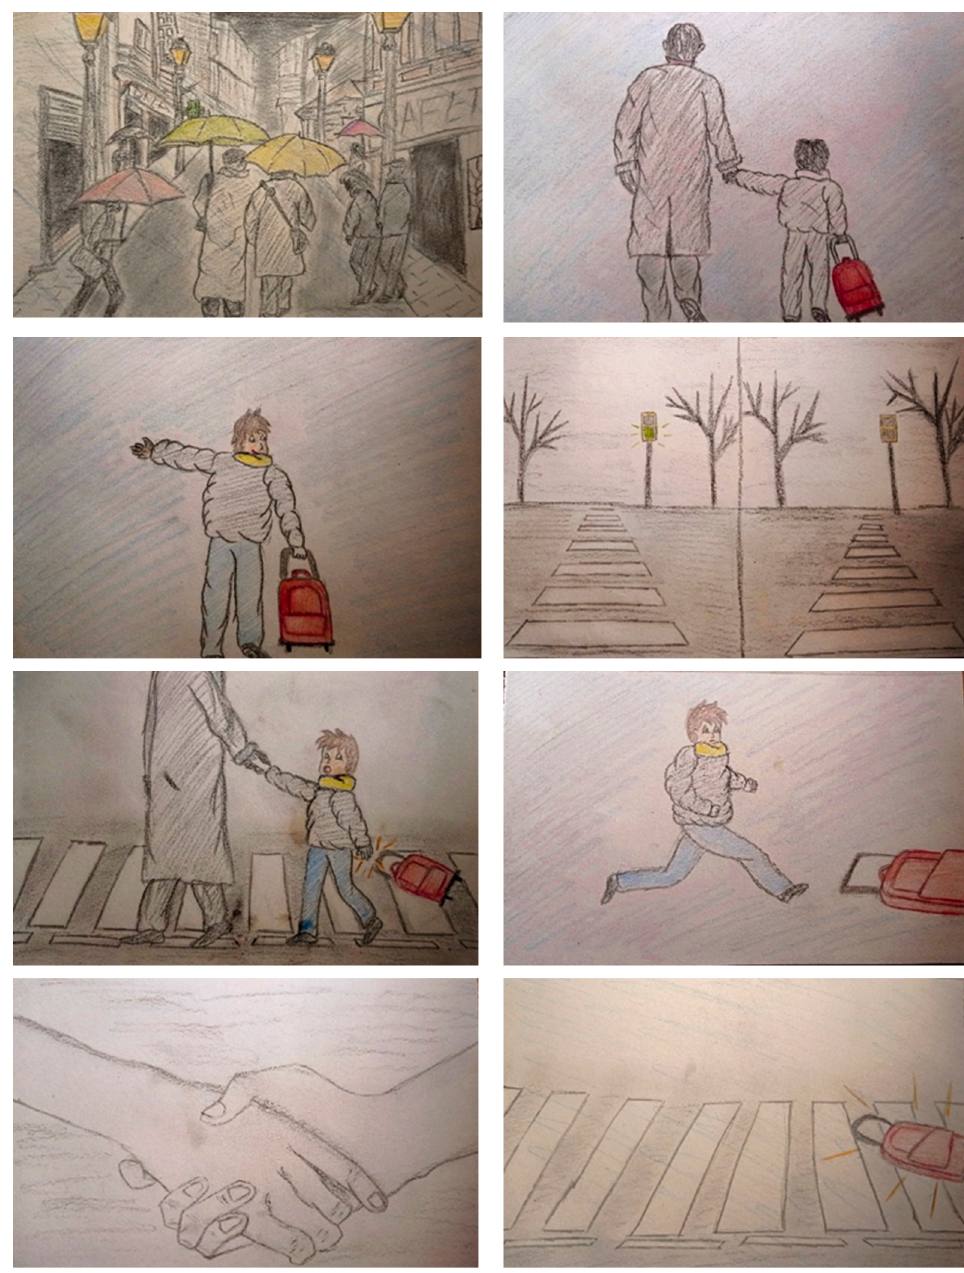
Figure 1. Pictures of events 1 to 4 of Scene 1.